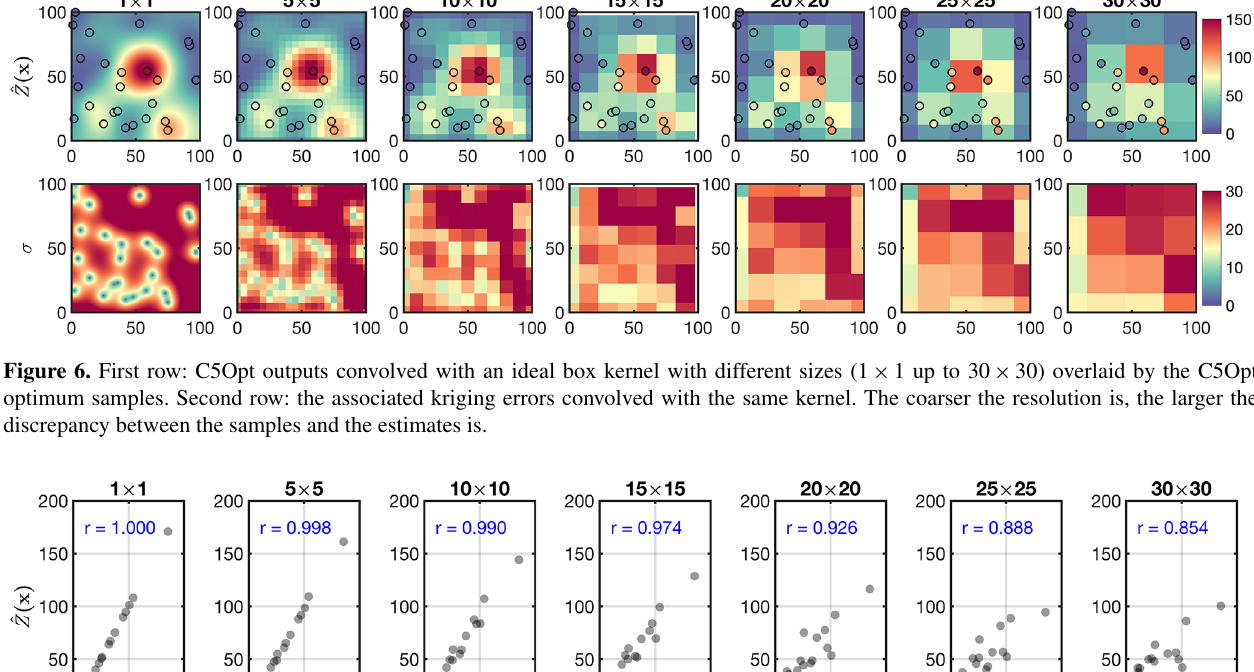
data to gridded data when the field exhibits substantial spa- tial